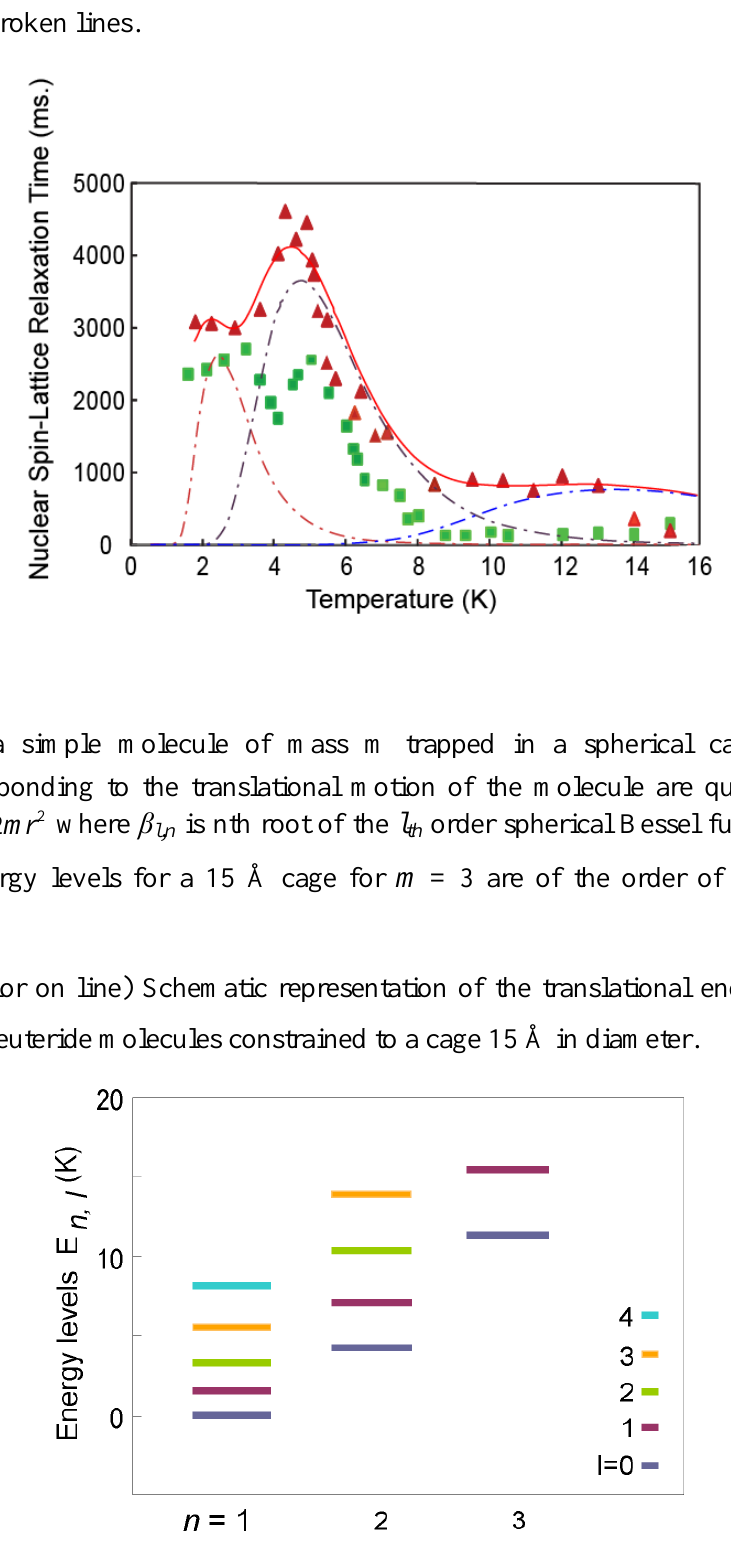
Figure 7. Observed variation of the hydrogen deuteride proton spin-lattice relaxation with temperature for molecules adsorbed in zeolite 13× with coverages of 1.0 molecule per cage (squares) and 0.5 molecules per cage (triangles). The solid line shows the contribution assuming Shottky level specific heats for three discrete energy levels. Each contribution is shown by the broken lines.